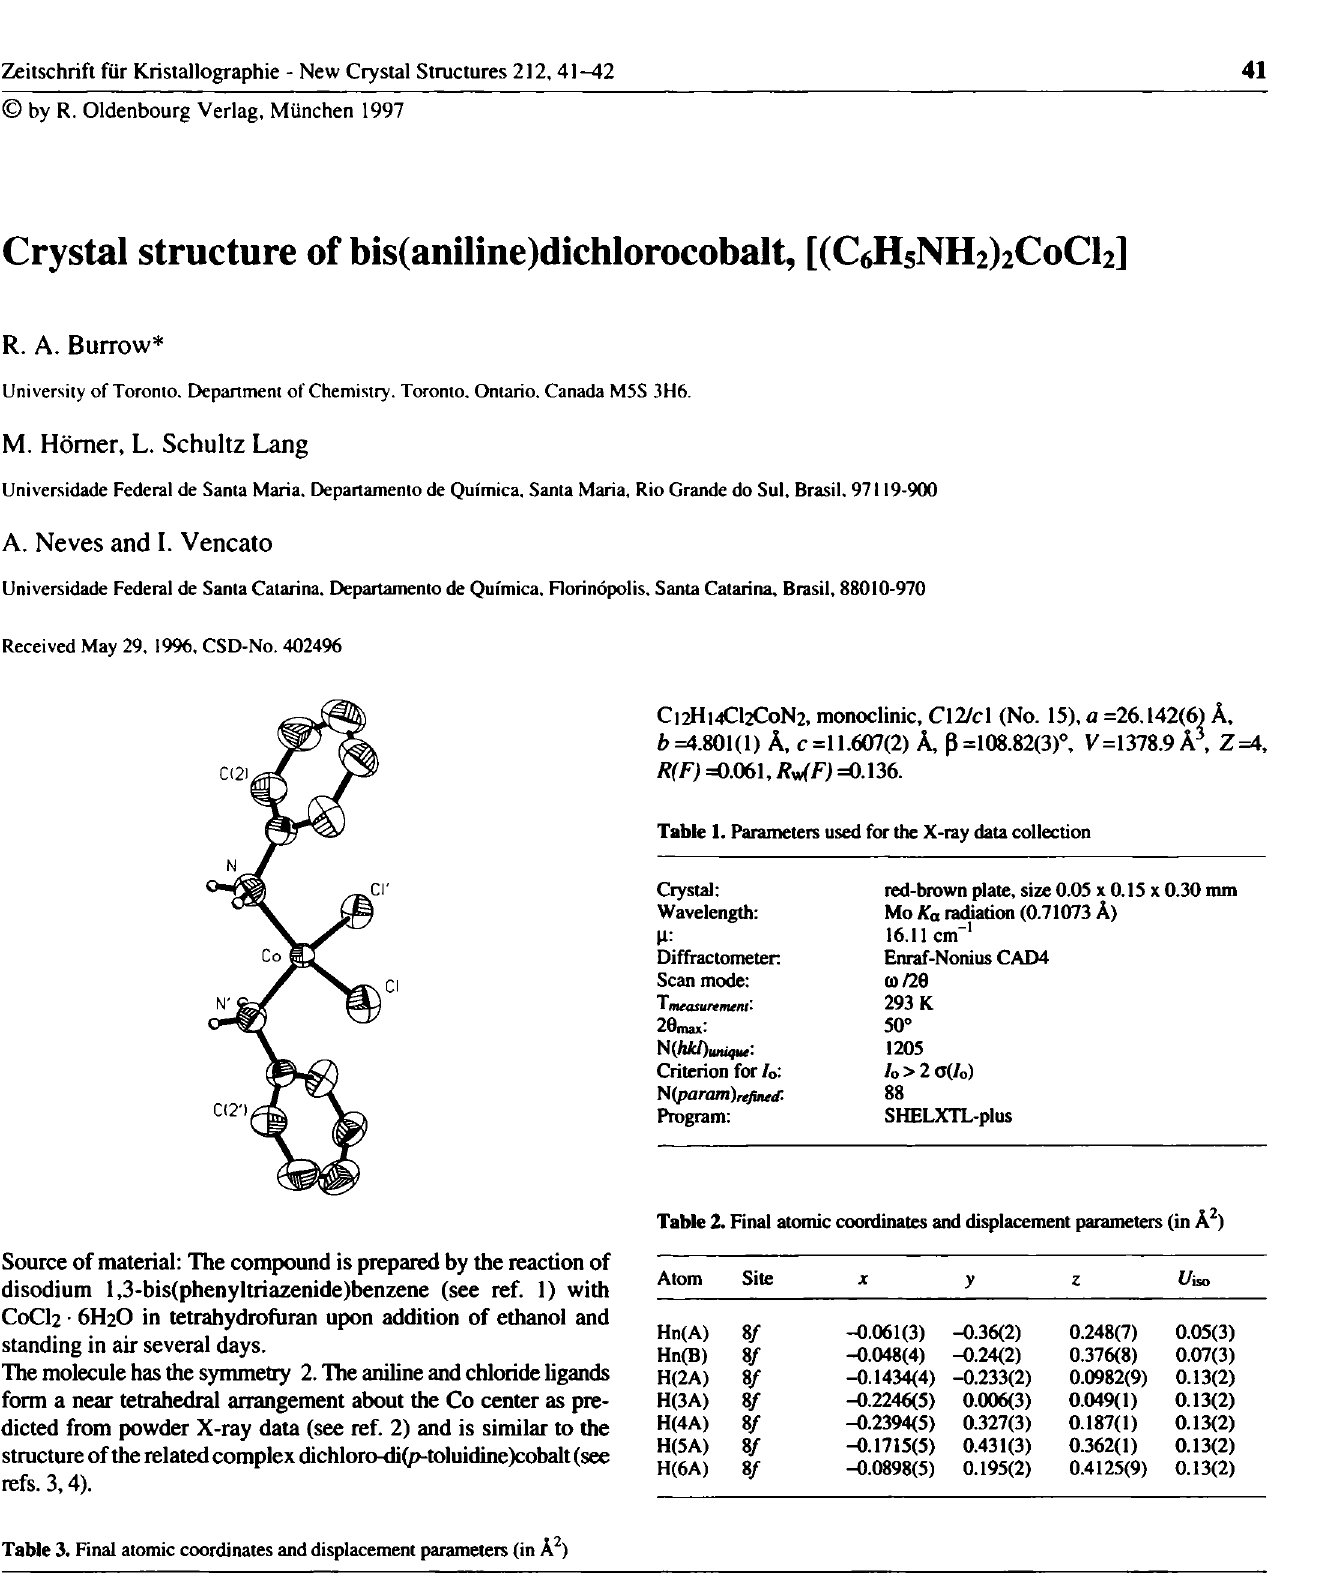
Table 3. Final atomic coordinates and displacement parameters (in Ä 2 )